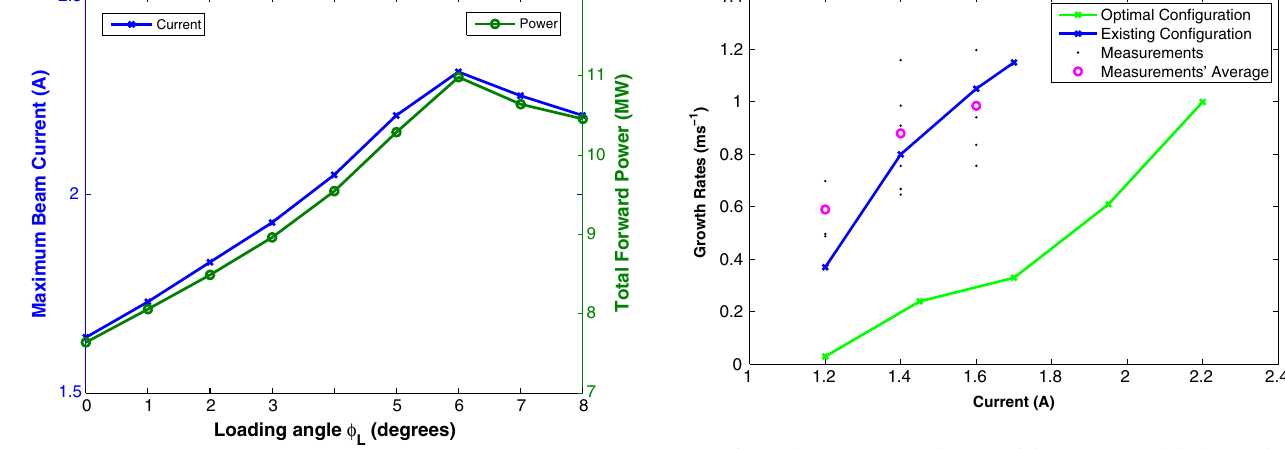
FIG. 4. (Color) HER maximum achievable beam current and total forward power as a function of the loading angle (cid:3)